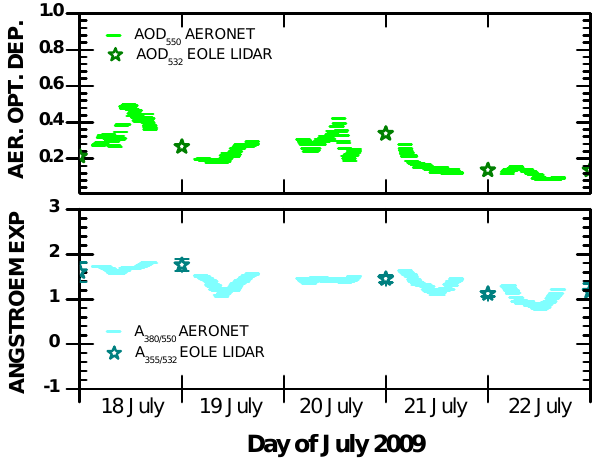
Fig. 7. Aerosol optical depth (AOD) at 550nm and extinction- related ˚Angstr ¨ om exponent (380/550nm) from sun photometer measurements (lines), as well as AOD (532nm) and extinction- related ˚Angstr¨om exponent (355/532nm) derived from Raman lidar measurements (stars) on 18, 19, 20 and 21 July 2009.